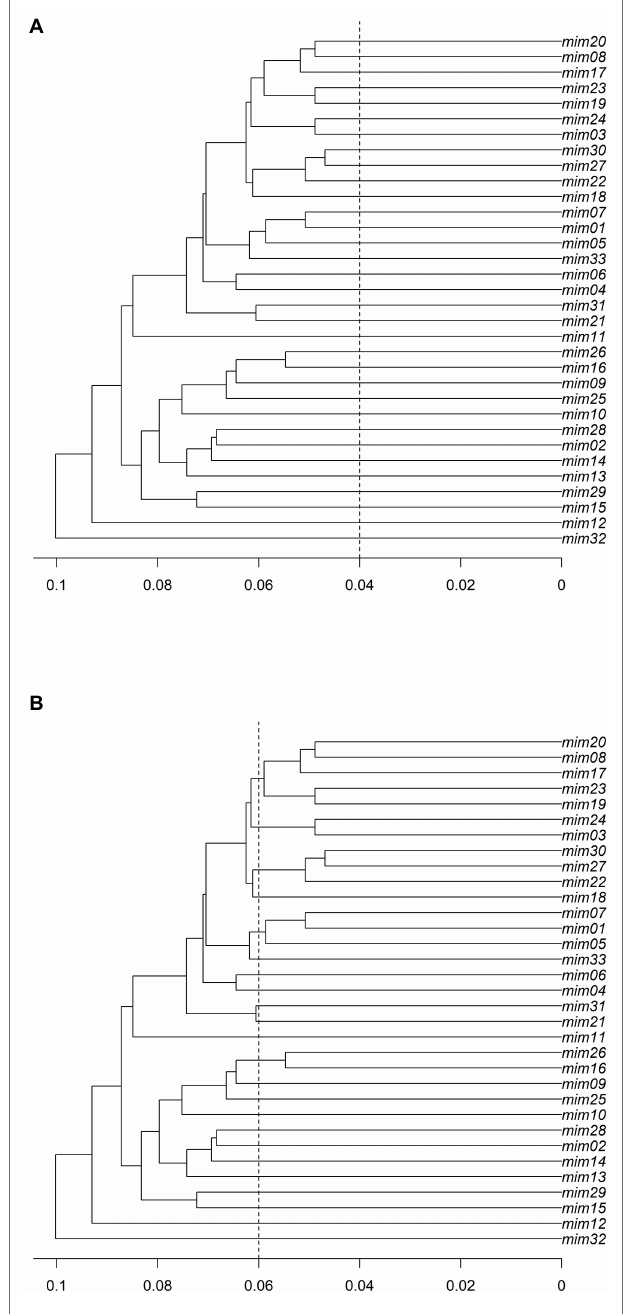
FIGURE 3 | The ultrametric topology trees for the M. catharinensis population based on genetic distances (horizontal axis) and using a threshold of (A) 0.04 and (B)